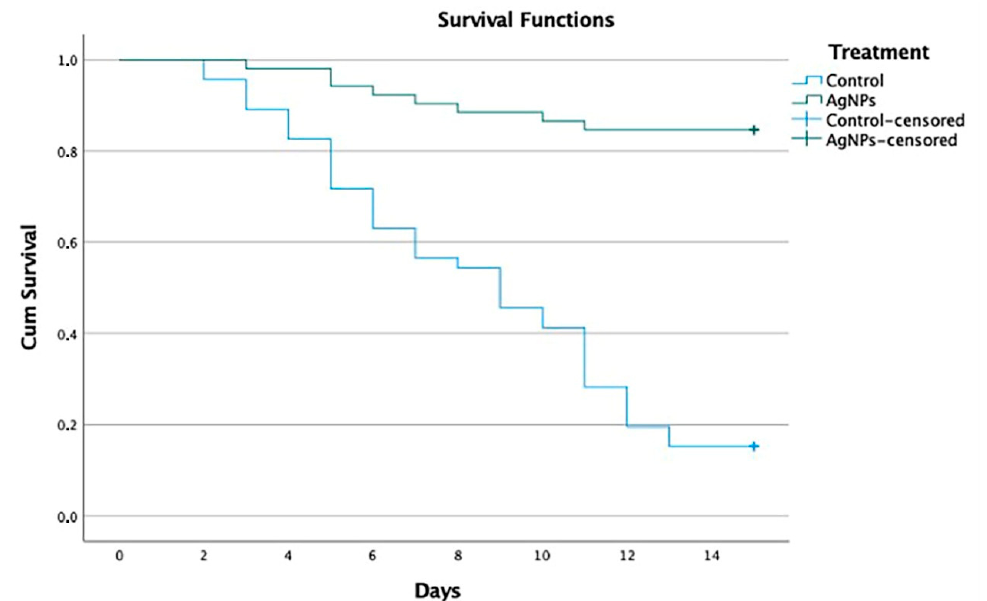
Figure 1. Comparison of survival rates between Groups 1a and 1b. In Group 1a (experimental), the probability of survival was maintained at above 85%, whereas in group 1b (control), this curve declined on day 13 down to 15%.